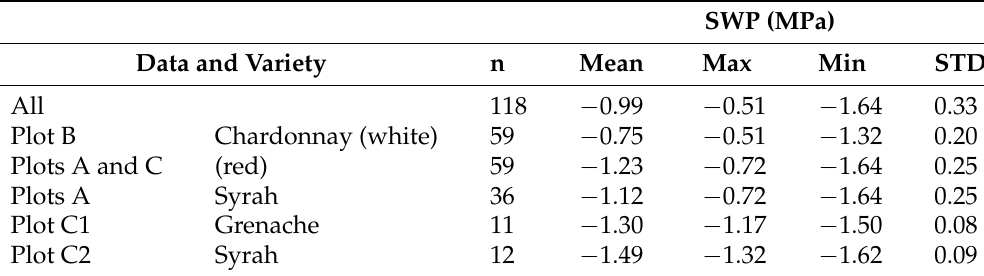
Table 4. Synthesis of Stem Water Potential values for each plot. n—number of samples; MPa— MegaPascal; STD—standard deviation.